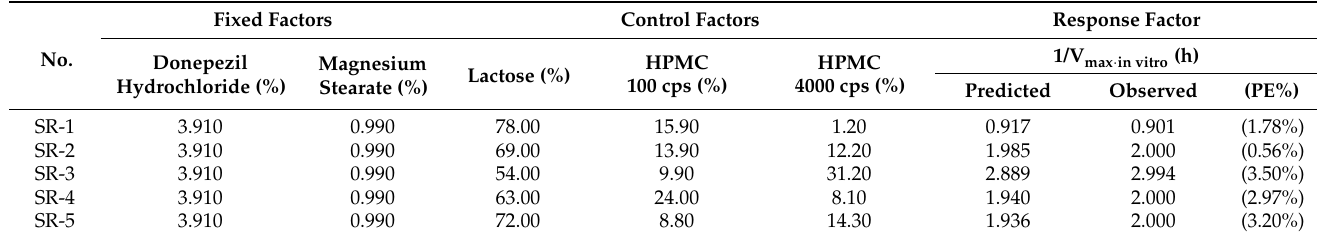
Table 2. The composition ( w / w %) of selected donepezil SR tablets and a comparison between model-predicted and observed response factors for external